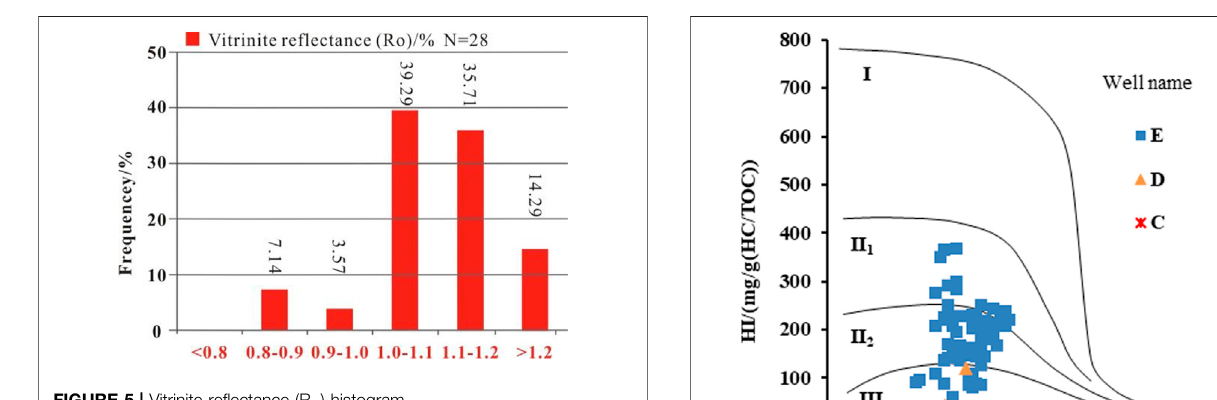
FIGURE 5 | Vitrinite re fl ectance (R O ) histogram.